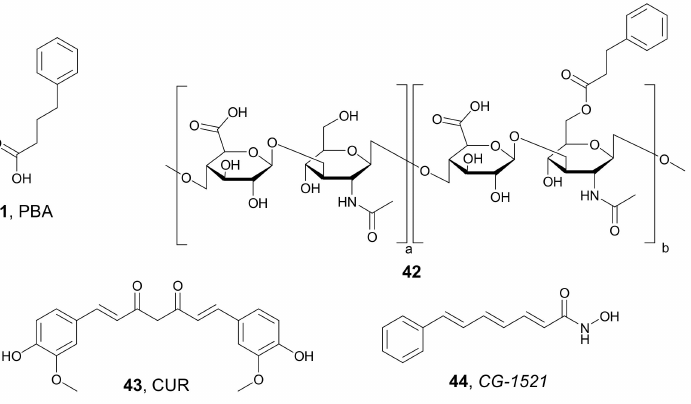
Figure 21. Chemical structures of PBA 41 , its HA-based NPs 42 , CUR 43 , and CG-1521 44 .